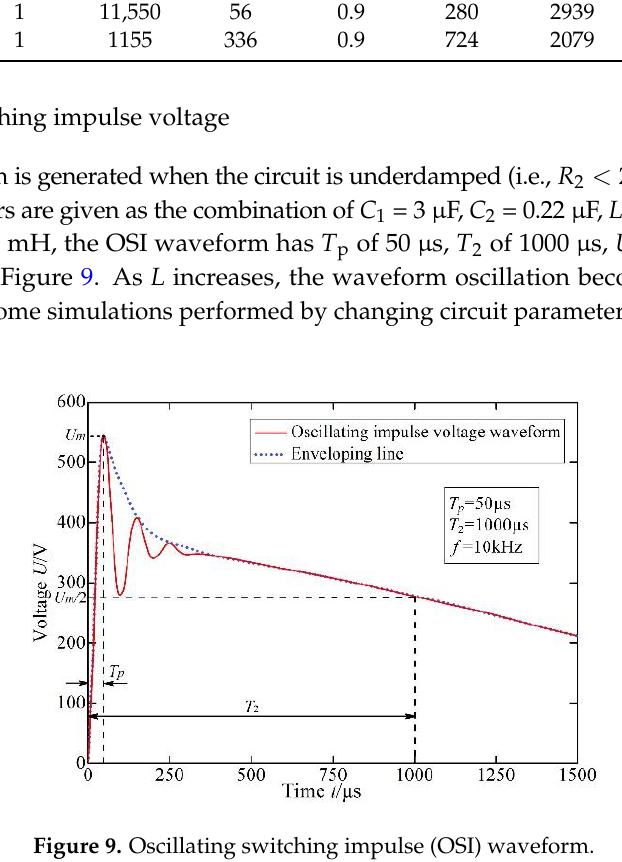
Table 1. Waveform parameters of SI voltage and their corresponding circuit parameters.